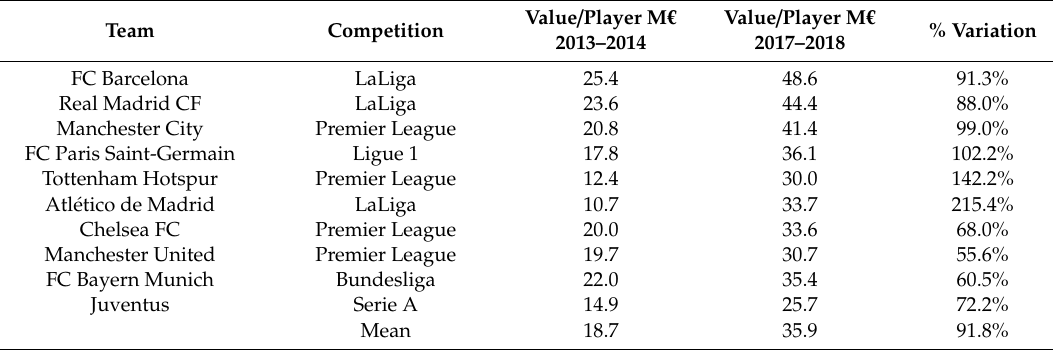
Table 1. Trends in player mean market values over the period